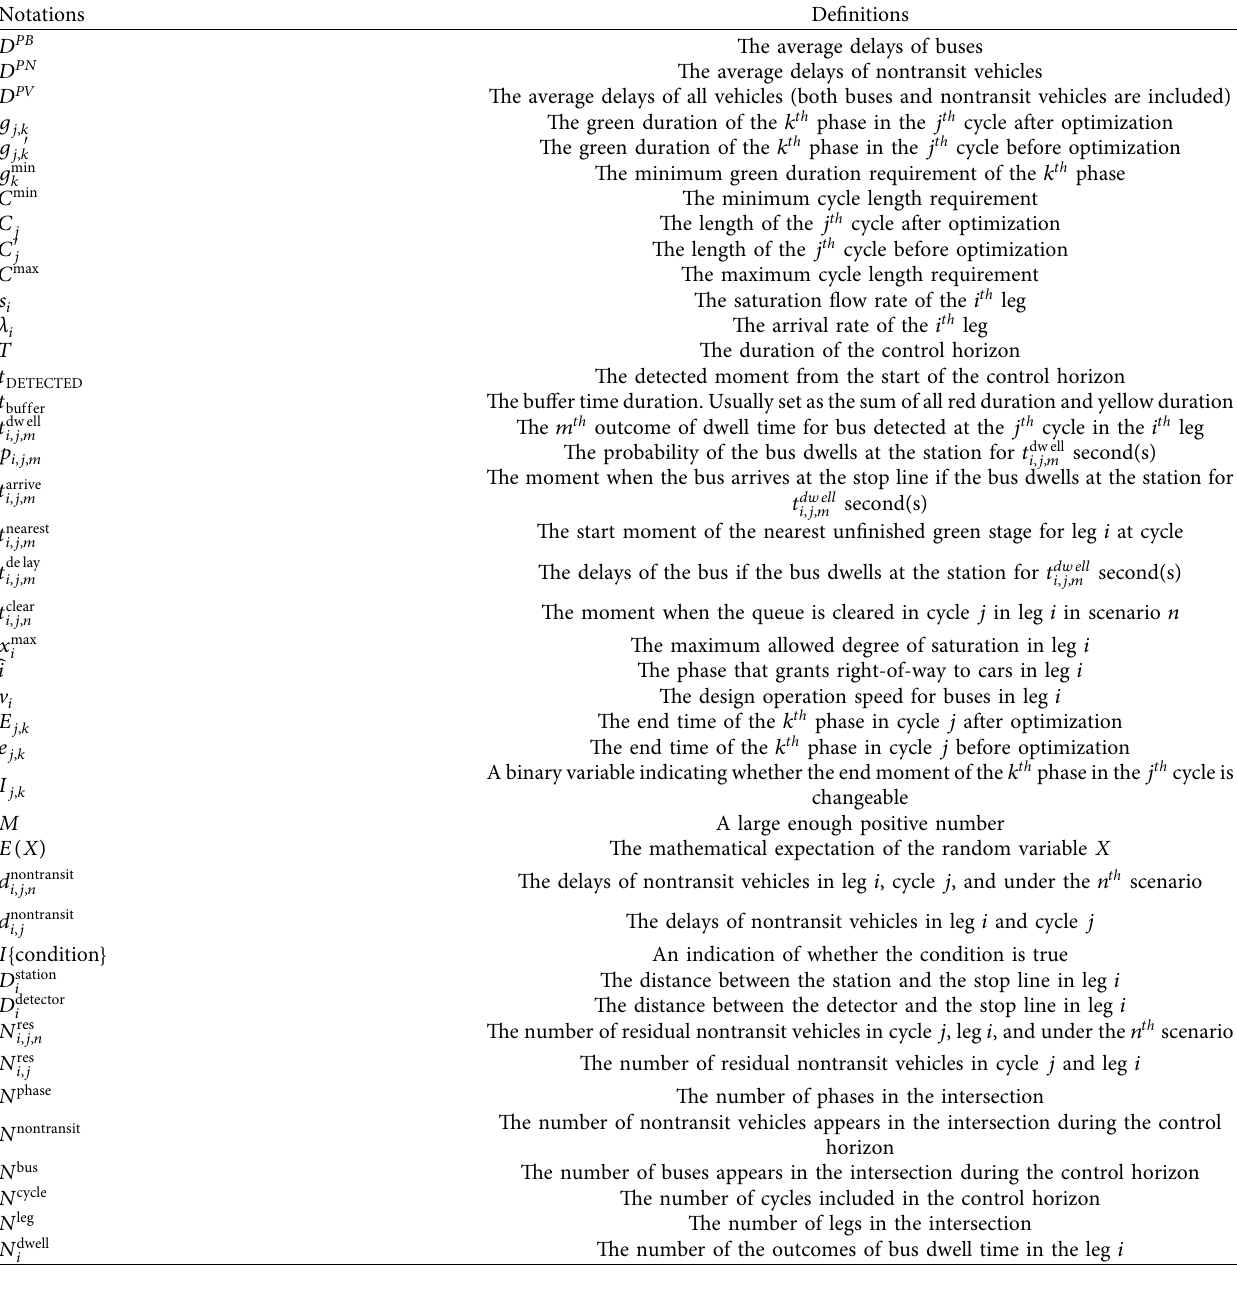
Table 1: Notations and